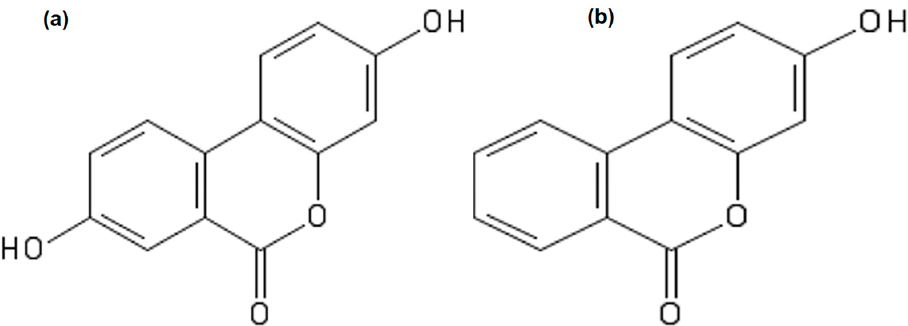
Figure 1. Chemical structure of urolithins. Urolithin A ( a ), urolithin B ( b